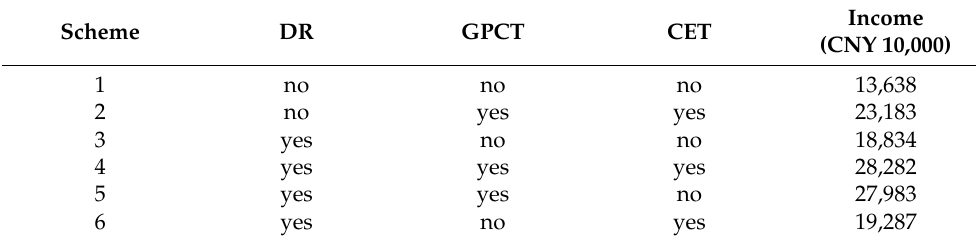
Table 3. Planning case